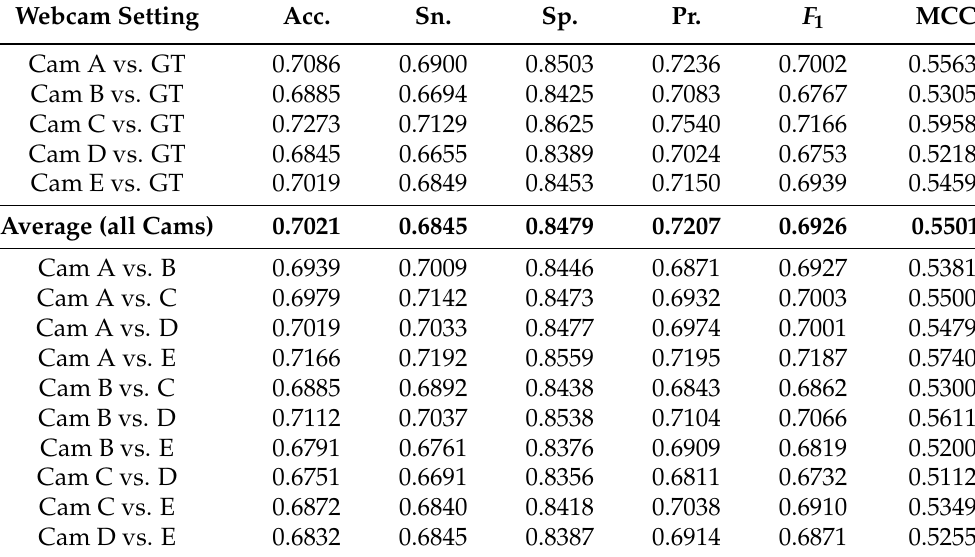
Table 4. Performance evaluation of proposed system for eye setting attributes detection. Acc.: accuracy, Sn.: Sensitivity, Sp.: Specificity, Pr.: Precision, F 1 : F 1 score, MCC: Matthews Correlation